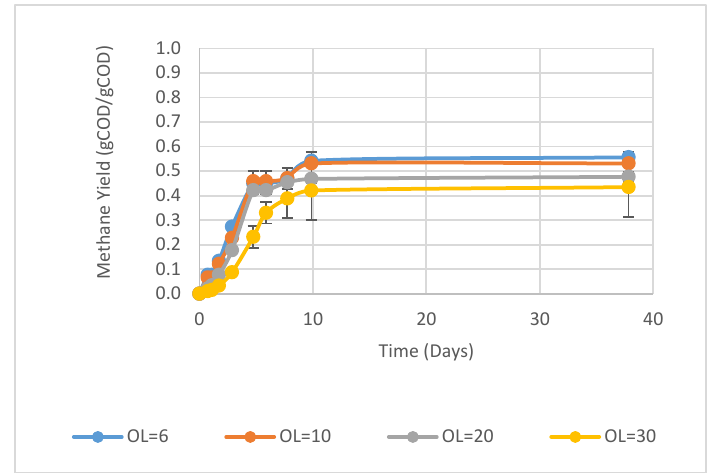
Figure 2. Methane yield of H170 under thermophilic condition under di ff erent organic loadings